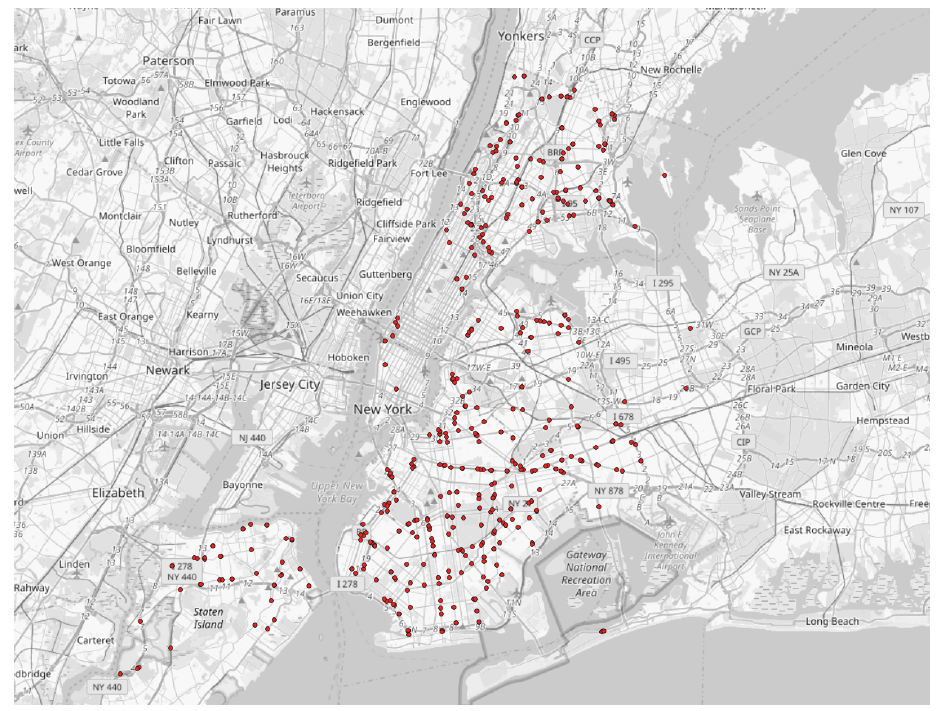
Figure 2. NYC gas